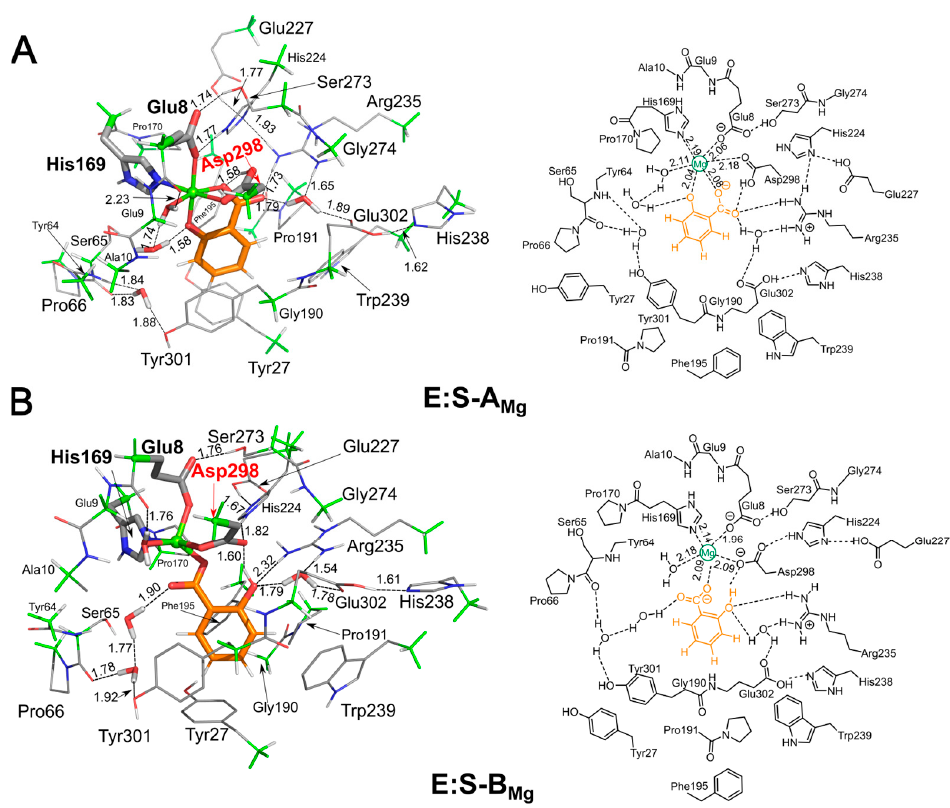
Figure 2. Optimized structures of enzyme–substrate complexes with ( A ) bidentate binding mode and ( B ) monodentate binding mode.